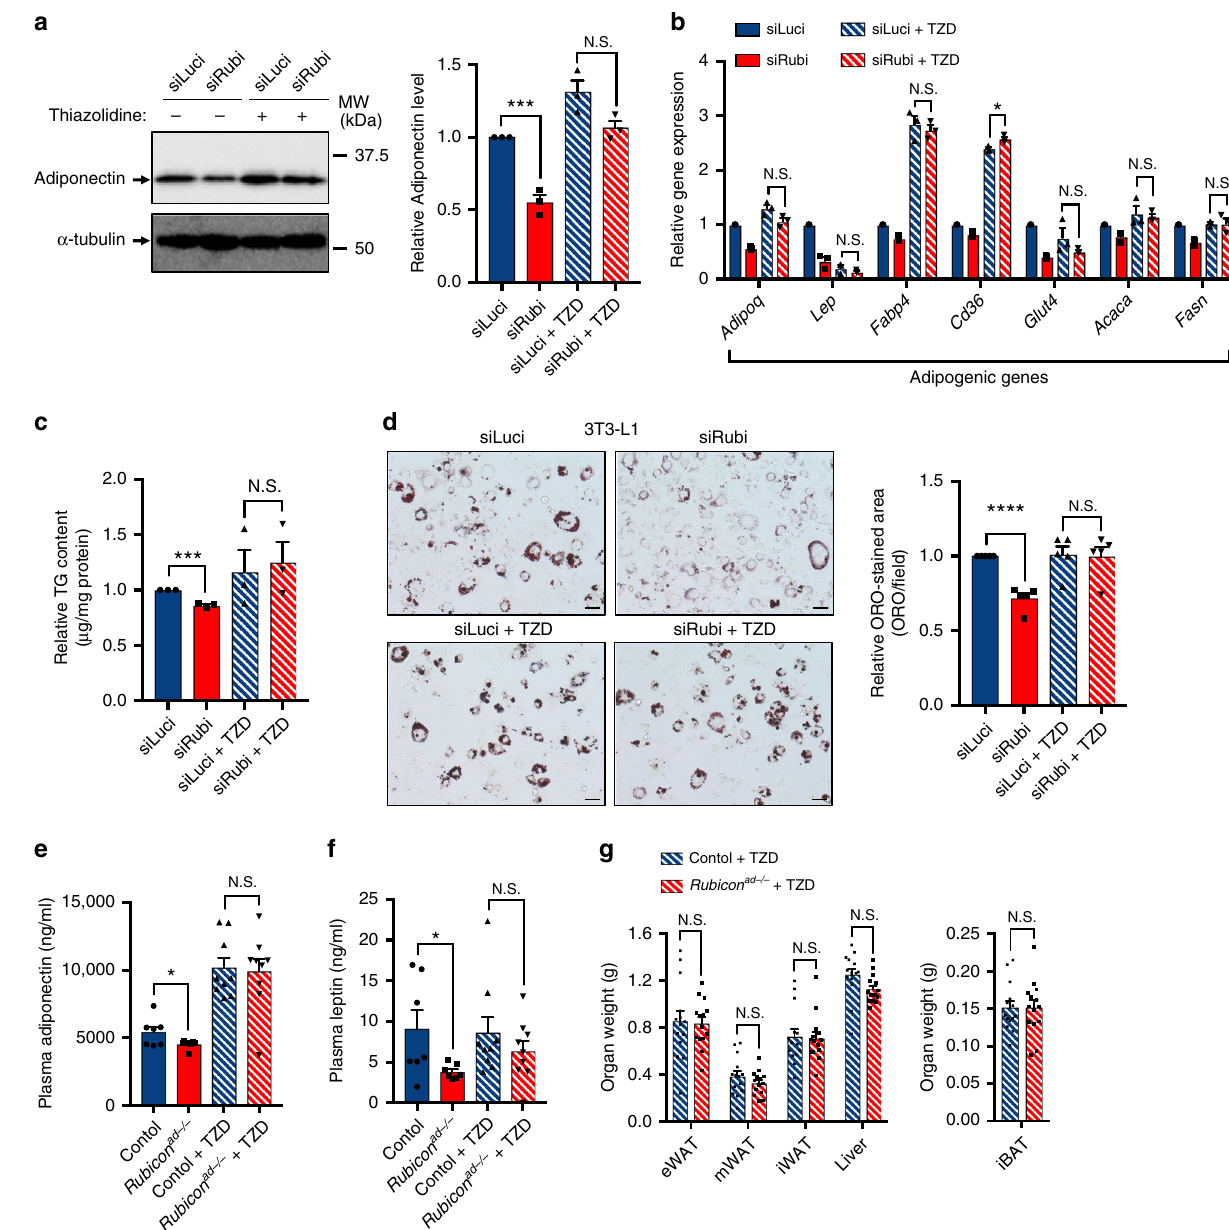
Fig. 5 PPAR γ activation recovers adipocyte dysfunction caused by suppression of Rubicon. a Immunoblotting to detect adiponectin in Luciferase - or Rubicon -knockdown 3T3-L1 cells treated with or without 10 μ M pioglitazone. Knockdown, with or without TZD treatment, was performed for 48 h starting on day 8 after induction of differentiation. n = 3 independent experiments. Quanti fi cation of adiponectin levels is shown in the graphs at right. b Relative mRNA expression of adipogenic genes in Luciferase- or Rubicon -knockdown 3T3-L1 cells treated with or without 10 μ M pioglitazone. Knockdown, with or without TZD treatment, was performed for 48 h starting on day 8 after induction of differentiation. n = 3 independent experiments. c Relative triglyceride content in Luciferase- or Rubicon -knockdown 3T3-L1 cells treated with or without 10 μ M pioglitazone. Knockdown, with or without TZD treatment, was performed for 72 h starting on day 8 after induction of differentiation. n = 3 independent experiments. d Representative images of ORO staining in Luciferase- or Rubicon -knockdown 3T3-L1 cells treated with or without 10 μ M pioglitazone. Knockdown, with or without TZD treatment, was performed for 72 h starting on day 8 after induction of differentiation. Scale bars, 50 μ m. n = 5 independent experiments. Quanti fi cation of relative ORO-stained area is shown in the graphs at right. Plasma adiponectin ( e ) and leptin ( f ) levels in control or Rubicon ad − / − mice treated with or without 0.02% pioglitazone for 3 weeks. n = 7 mice (without TZD); n = 9 mice (with TZD). g Organ weight of eWAT, mWAT, iWAT, iBAT and liver from control or Rubicon ad − / − mice treated with 0.02% pioglitazone for 3 weeks. n = 14 mice. Error bars indicate means ± SEM. Data were analysed by two-tailed Student ’ s t test ( a – g ). P value from left to right: 0.0009, 0.0650 ( a ), 0.0586, 0.3129, 0.5902, 0.0229, 0.2209, 0.7297, 0.9763 ( b ), 0.0002, 0.7647 ( c ), < 0.0001, 0.9078 ( d ), 0.0450, 0.8353 ( e ), 0.0441, 0.3403 ( f ), 0.8532, 0.2697, 0.8582, 0.0625, 0.9957 ( g ). * P < 0.05; ** P < 0.01; *** P < 0.001; **** P < 0.0001. N.S. not signi fi